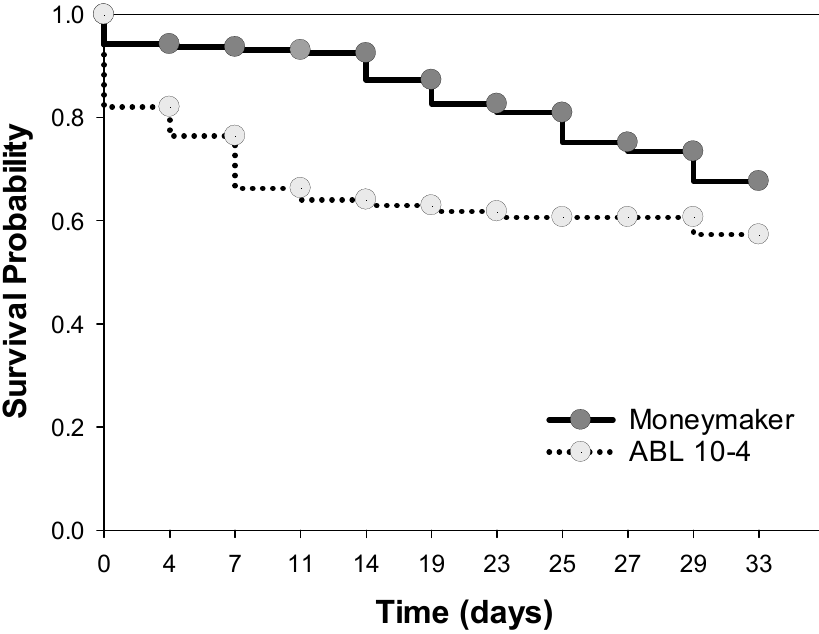
Figure 5. Trialeurodes vaporariorum survival probability on plants of Moneymaker and ABL 10-4 near-isogenic tomato lines during a period of 33 days after release. Survival time of T. vaporariorum on leaves of the lines was estimated based on the Kaplan–Meier estimator of the survivorship function [57]. Comparison of survivorship functions was performed by using the test described by Hosmer